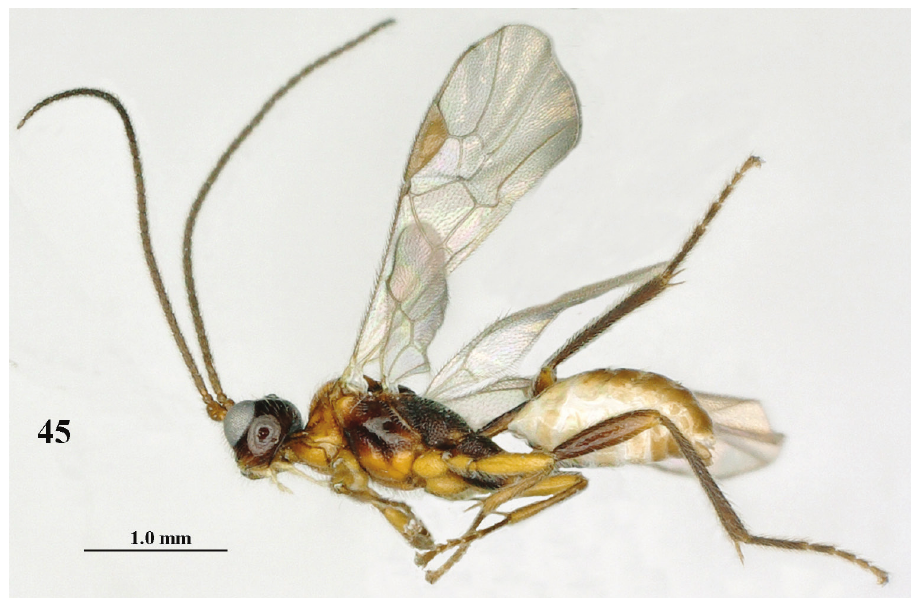
Figure 45. Mannokeraia punctata sp. n., ♂ , holotype, habitus, lateral aspect. with medium-sized transverse space between closed mandibles and clypeus; length of malar space 0.9 times basal width of mandible; mandible slightly convex medially and with few punctures, both apical teeth